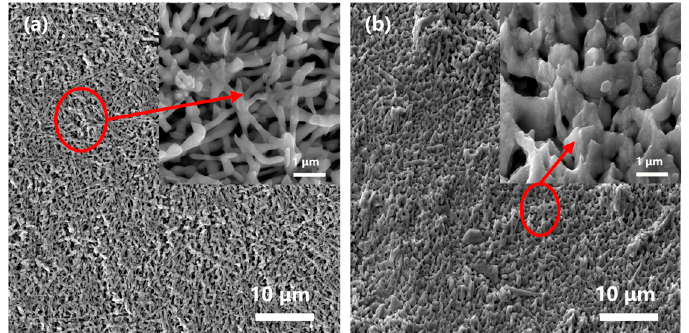
Figure 12. Two typical SEM images of the fracture surface of the joint. ( a ) Fractured at interface, ( b ) Fractured at sintered silver nanowire film. The scale of each figure in the up-right corner is 1 μ m.